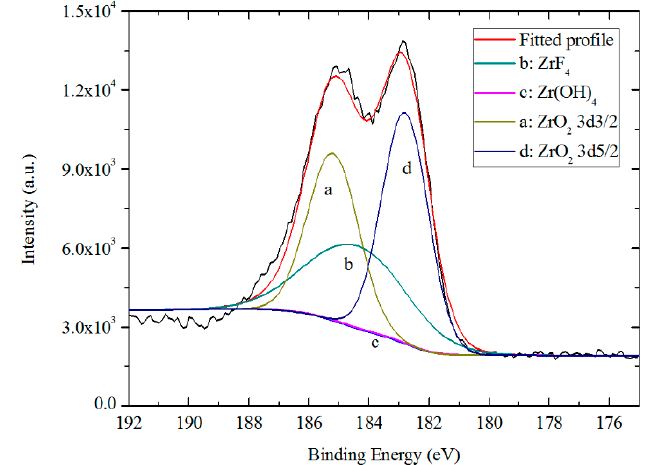
Figure 14. High resolution XPS spectrum and curve fitting for Zr 3 d photoelectron region for a TCC formed on Zn55Al for 180 s in TCP bath at 40 ◦